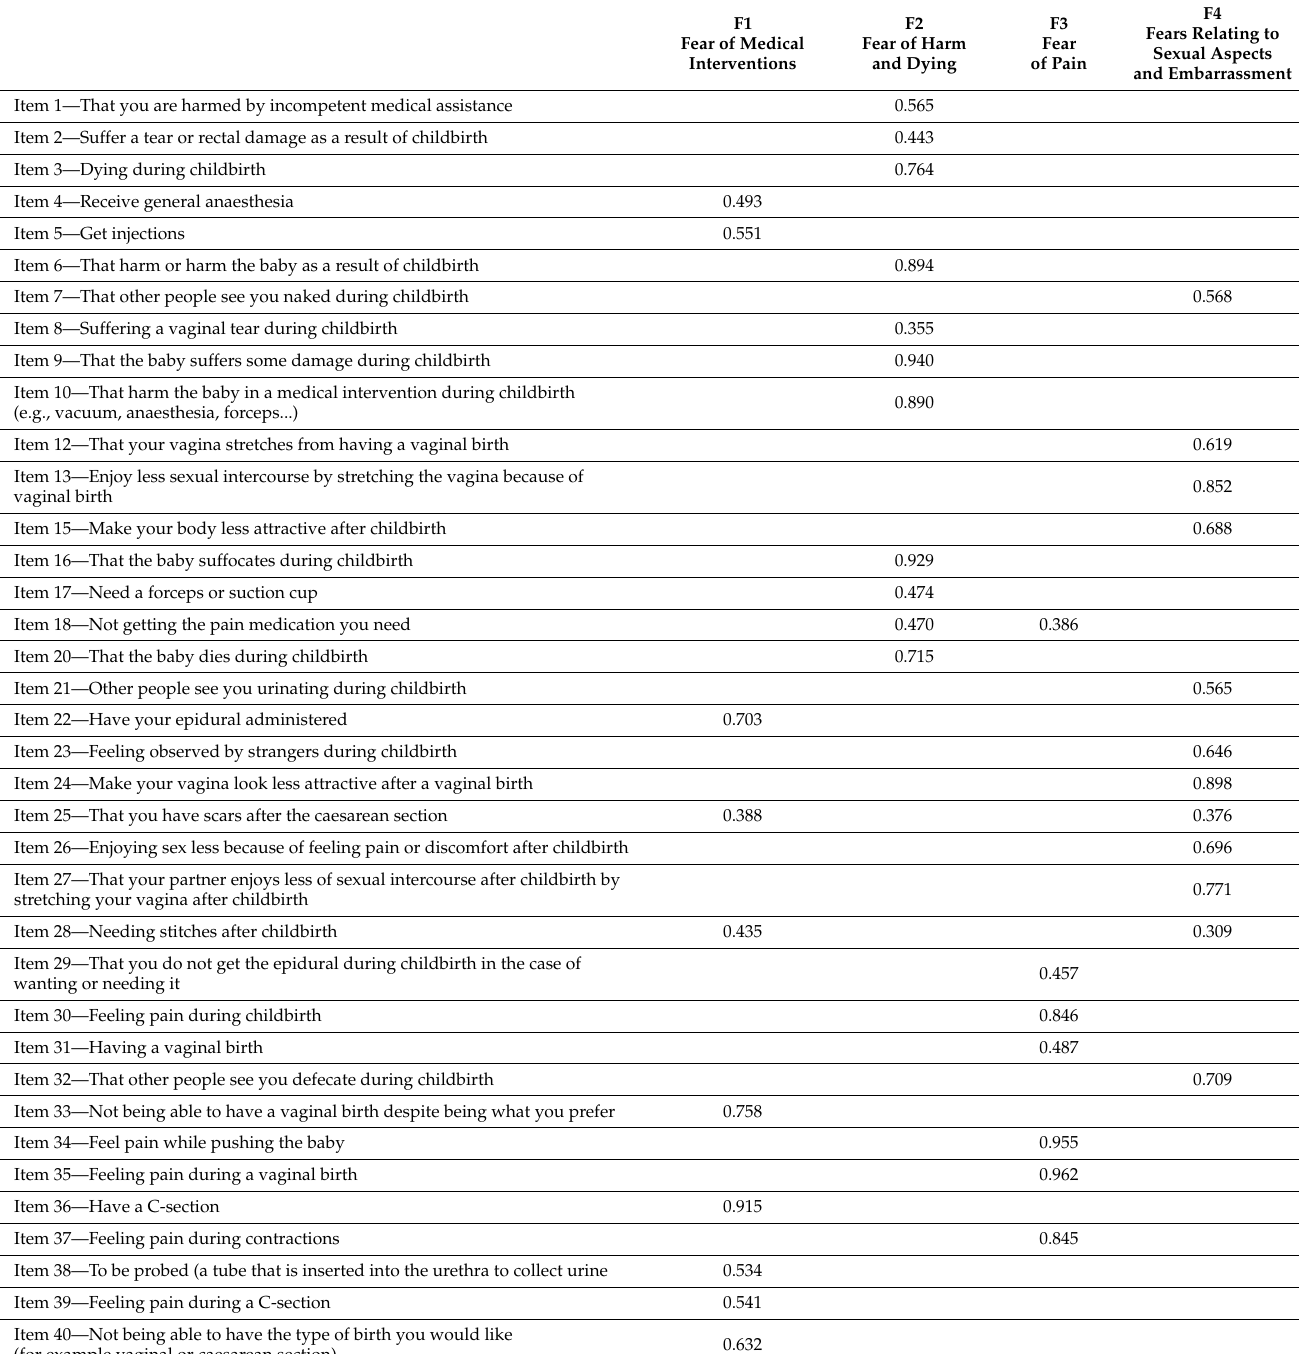
Table 4. Factorial loads (after rotation) of the model obtained from 4-factor, 37-item model in the second sample ( n = 278) (loadings lower than absolute 0.300